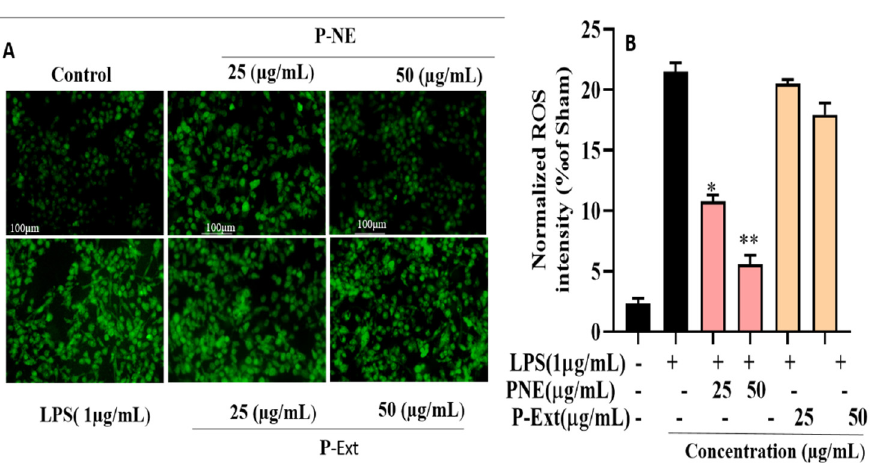
Figure 6. Cells were stained with ( A ) Superoxide detection assay kit/ROS using 200 magnification at fluorescence microscope and ( B ) Statistics analysis of fluorescence intensity of ROS staining. Data presented as ±SEM, * p < 0.05 ** p < 0.01 vs. LPS treated group. All treatment was performed three time.